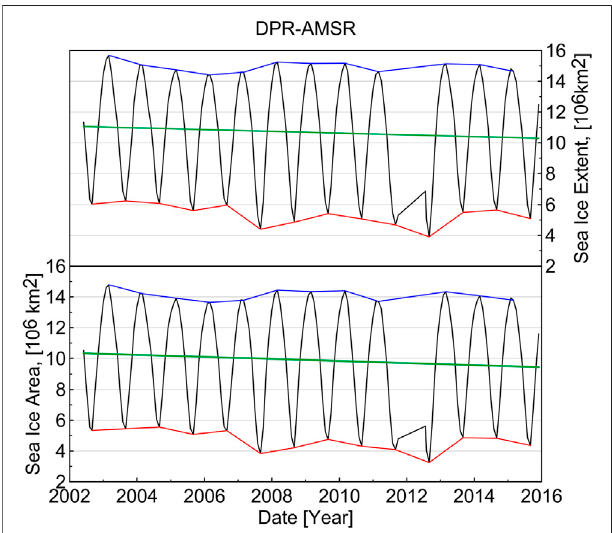
FIGURE 3 | Monthly sea ice area and sea ice extent from June 2002 to December 2015 in Arctic obtained from DPR-AMSR. Green lines are trends for all years, blue curves are the maximum for March, and red curves are the minimum for